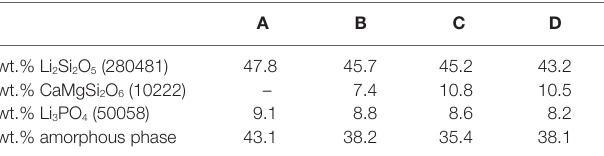
TaBle 4 | Quantitative composition of glass-ceramics after sintering and crystallization at 860°c for 5 min (icsD